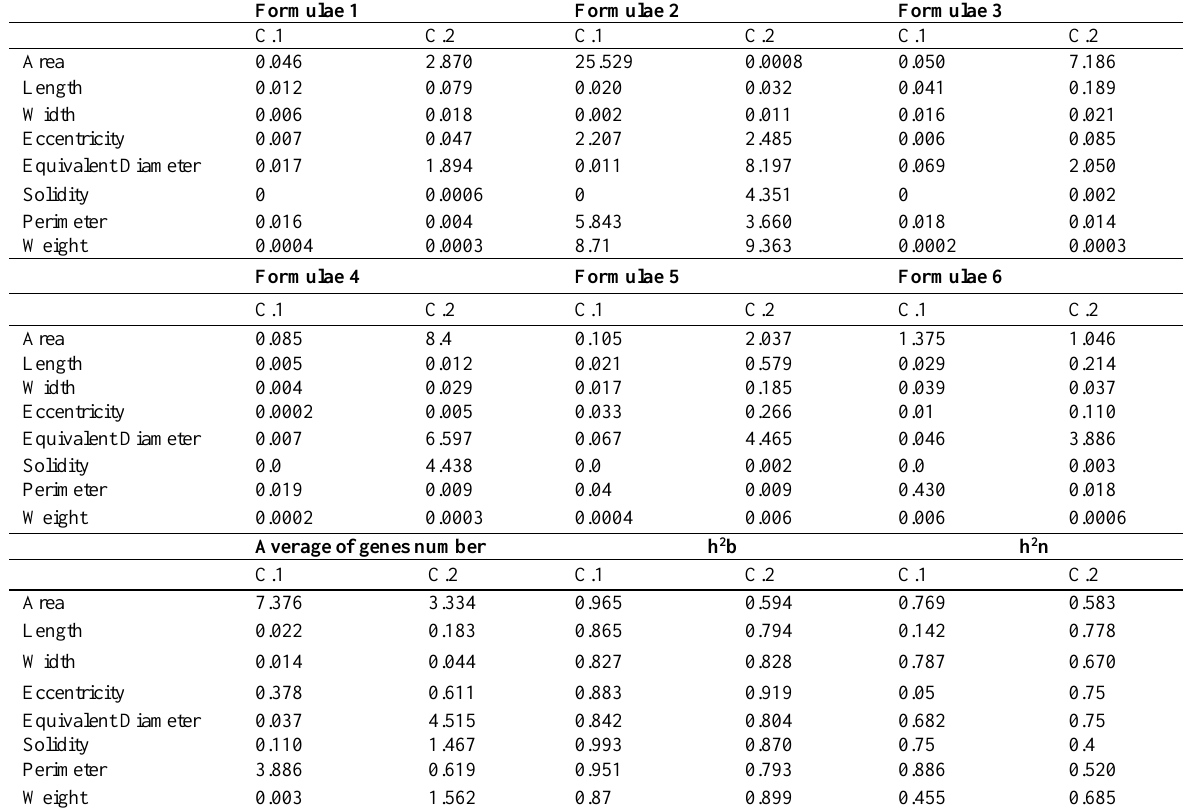
Table 3. Estimation of the number of genes and narrow and broad heritability for the studied